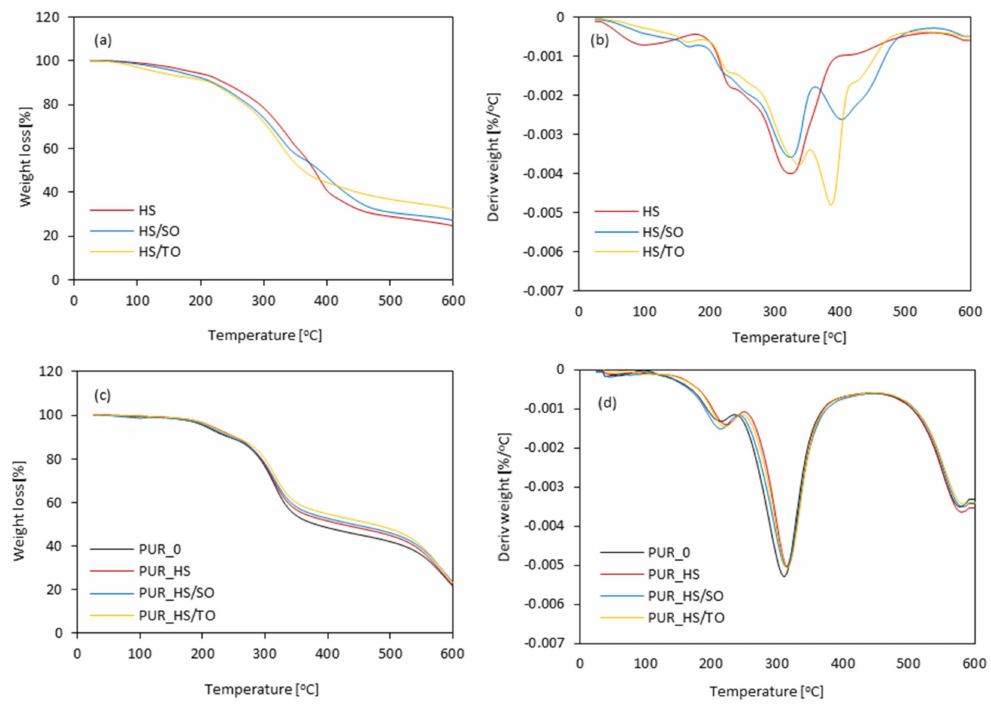
Figure 9. TG and DTG results obtained for ( a , b ) HS fillers, and ( c , d ) PUR